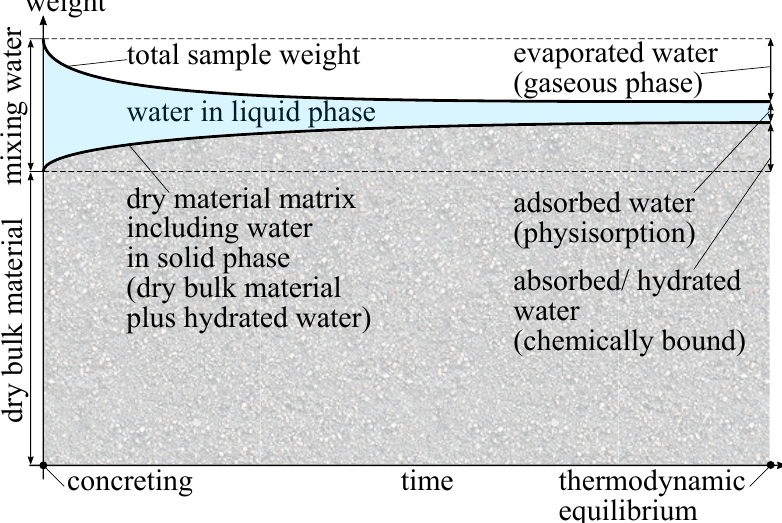
Figure 1. Schematic sketch of the evolution of the mixing water and its phase